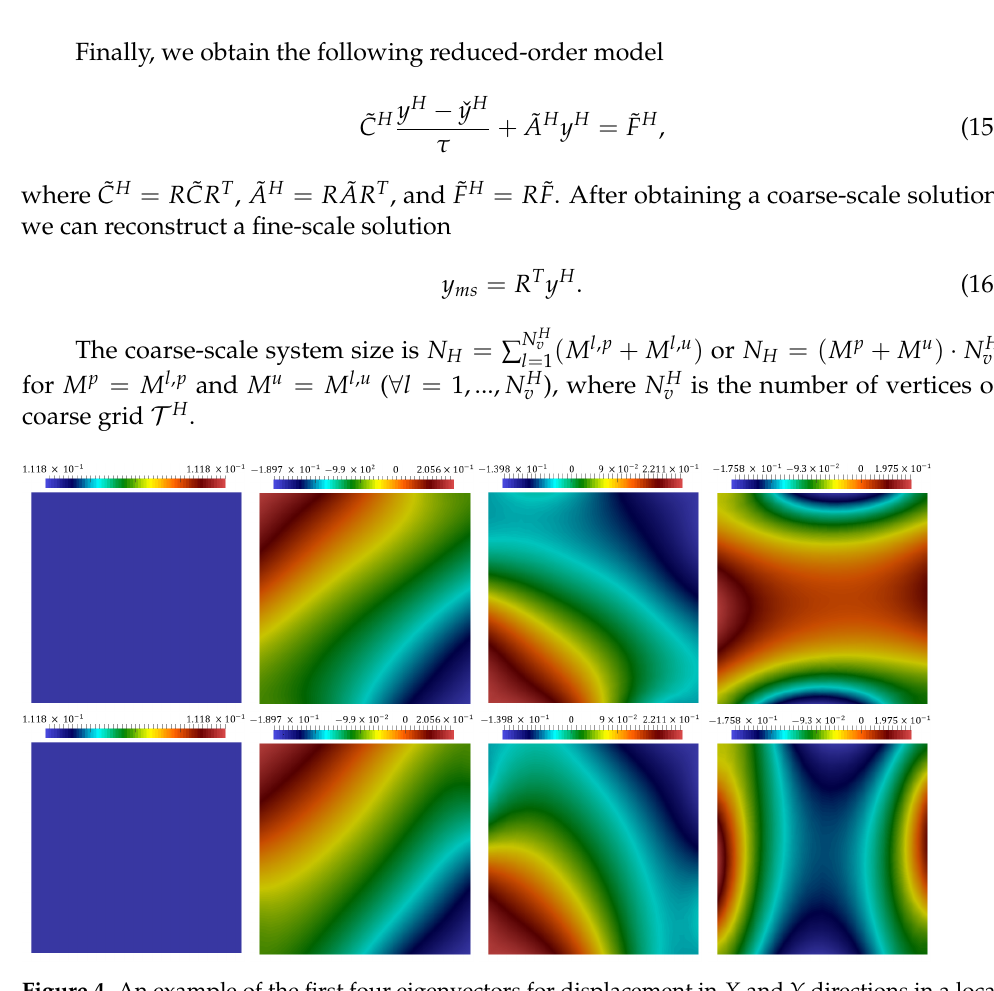
Figure 4. An example of the first four eigenvectors for displacement in X and Y directions in a local domain ω l